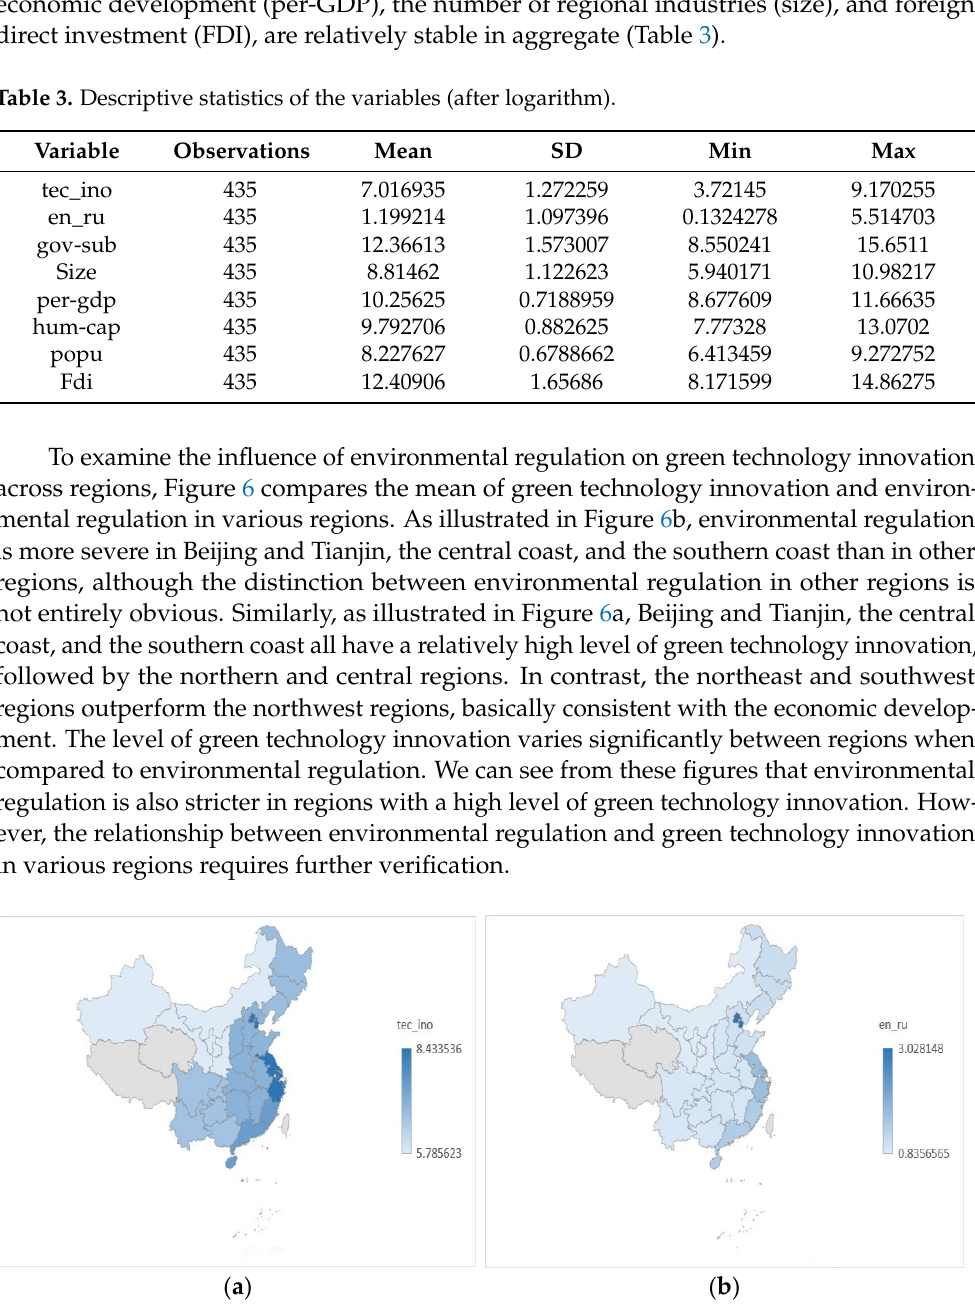
Figure 6. ( a ) The mean of green technology innovation in eight regions; ( b ) the mean of environmental regulation in eight regions. In these figures, the grey parts represent Qinghai and Tibet. Due to lack of data, the corresponding index values are not shown in the figure above.